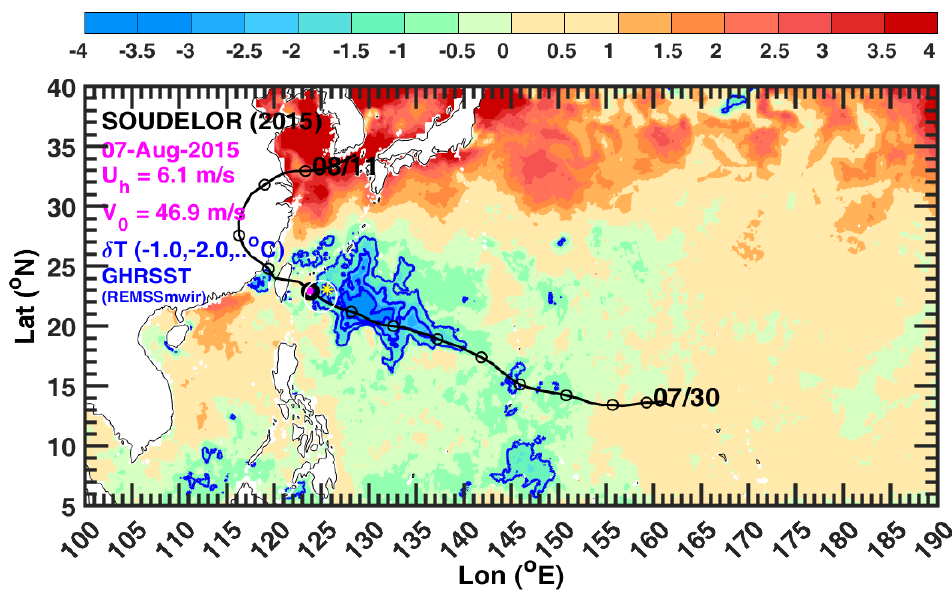
Figure 3. Deviation of satellite ‐ derived REMSS SST from monthly EN4 SST, δ T O (Equation (11); °C, shading, blue contours) on 7 August 2015, during Typhoon Soudelor (30 July–11 August 2015, track and daily circles; 7 August is marked magenta ×; the corresponding U h and V o in the display). The white circle with a radius of 150 km trailing the 7 August track point is where the minimum δ T O (i.e., maximum cooling, indicated by an asterisk *) is searched, and it is set to be the TC ‐ induced cooling δ T O for this day at the point.